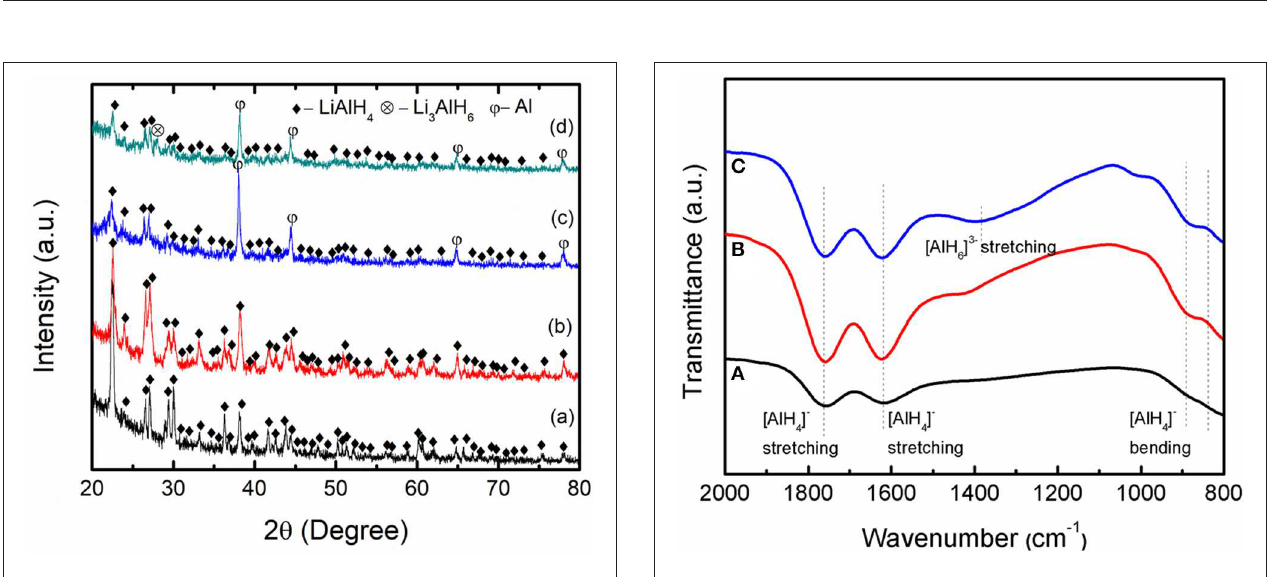
phase was not detected after the dehydrogenation process,